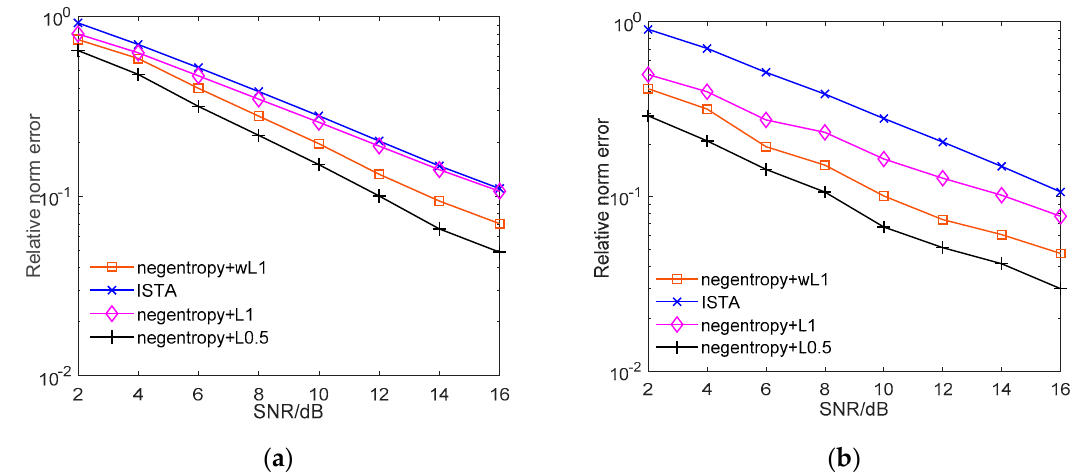
Figure 2. Relative norm error performance versus signal-to-noise ratio (SNR). ( a ) Comparison between ISTA and proposed algorithm with Gaussian noise; ( b ) comparison between ISTA and proposed algorithm with non-Gaussian noise.